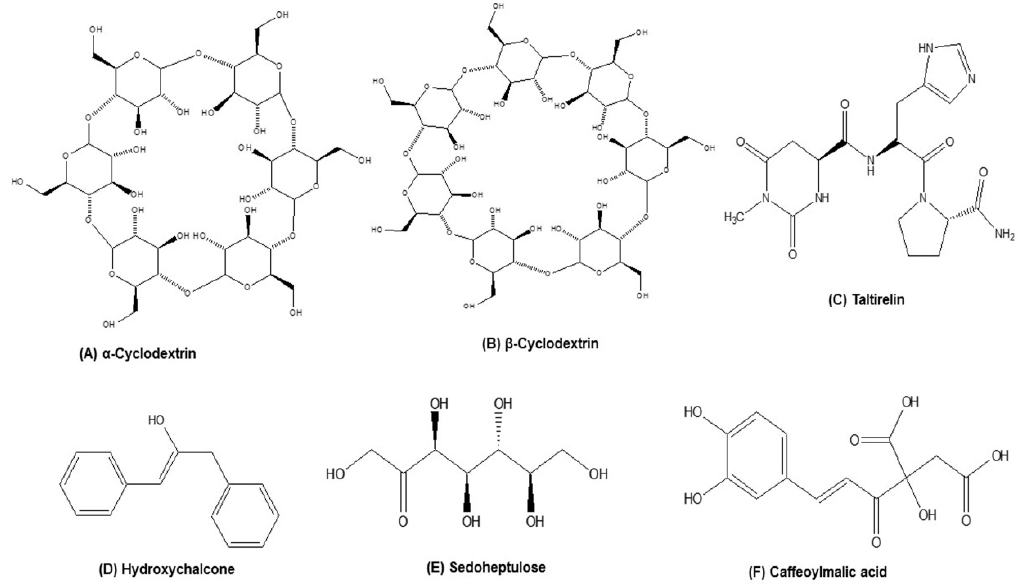
Figure 3. Chemical structures of selected patent agents targeting inflammaging.